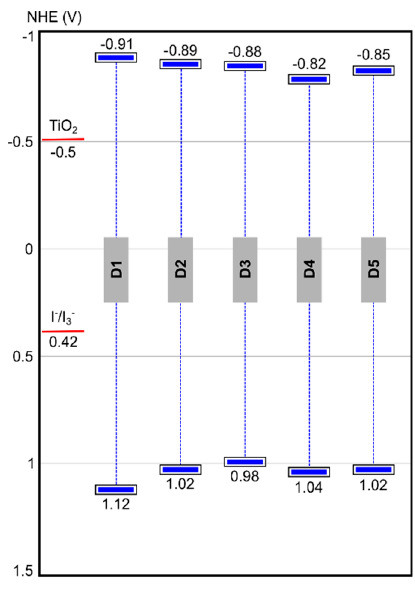
Figure 3. HOMO and LUMO levels of D1 – D5 .